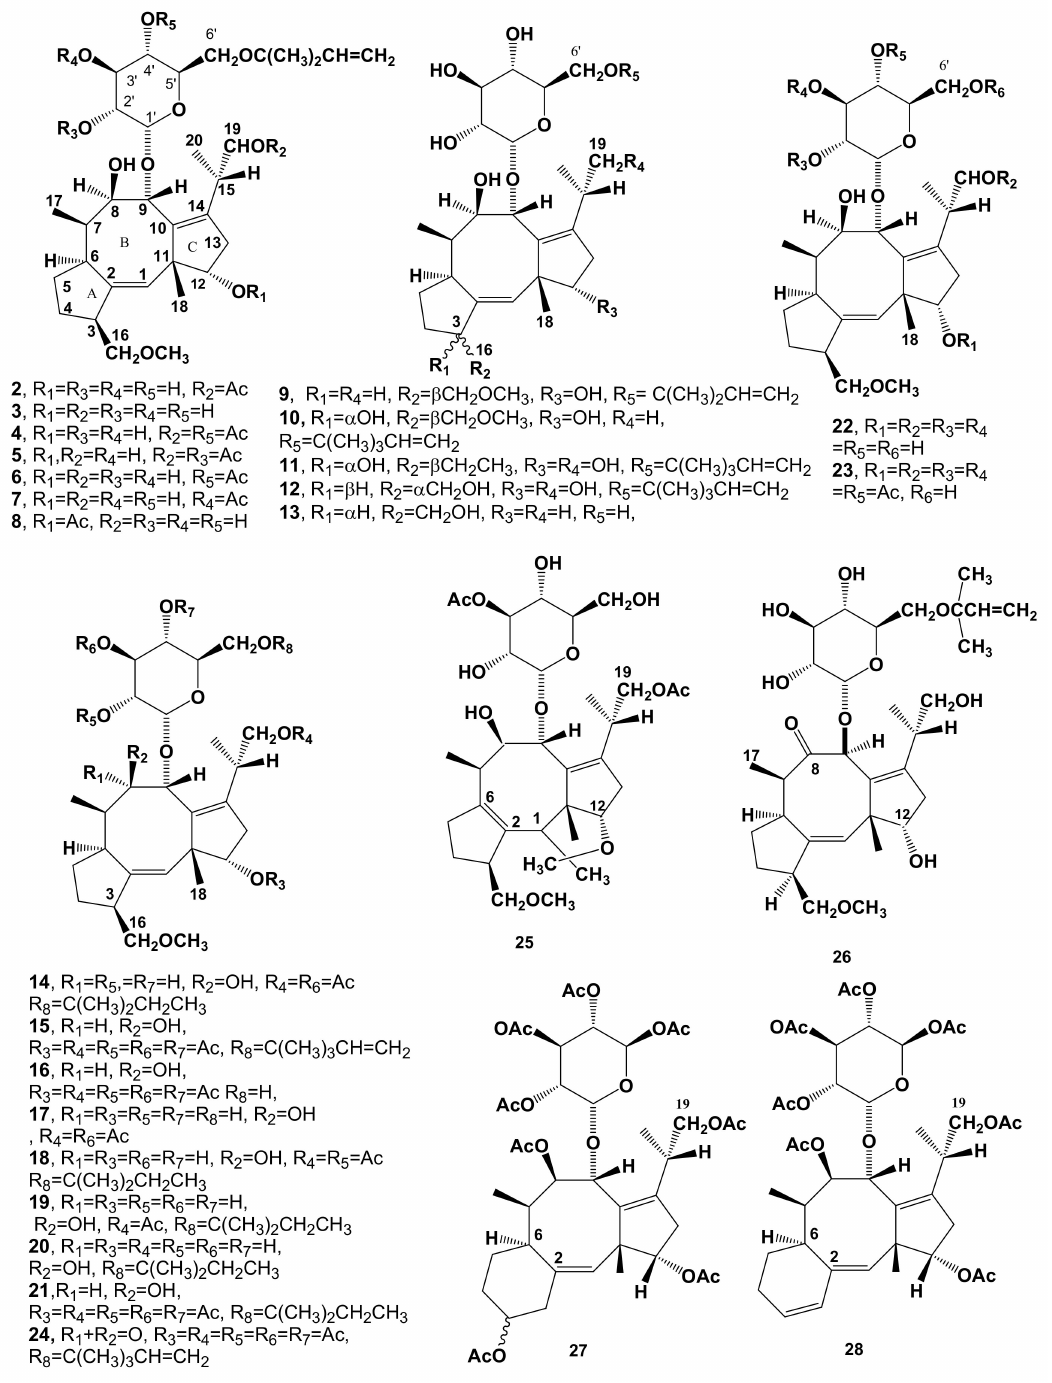
Figure 2. Chemical structures of FC major semisynthetic derivatives, and minor diterpenoid metabolites isolated from culture filtrates of Pamygdali, used in the biosynthetic and structure-activity relationship